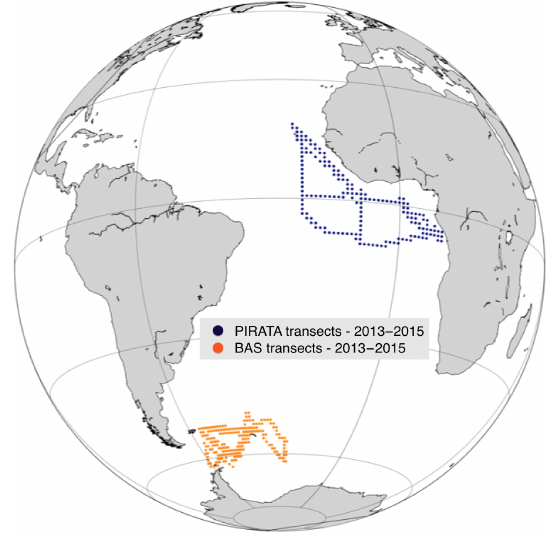
Figure 7. Map of PIRATA and BAS ship transects for the years